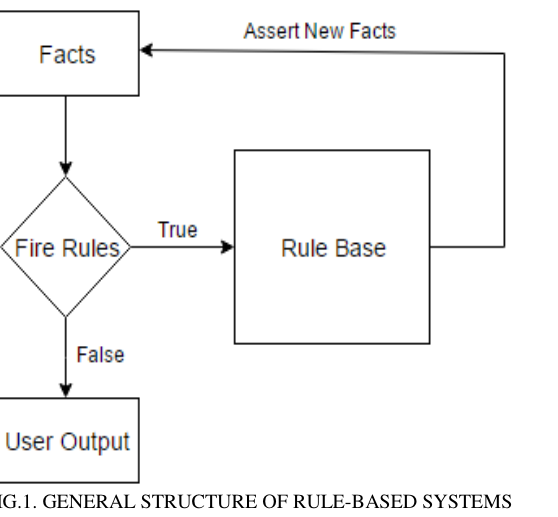
FIG.1. GENERAL STRUCTURE OF RULE-BASED